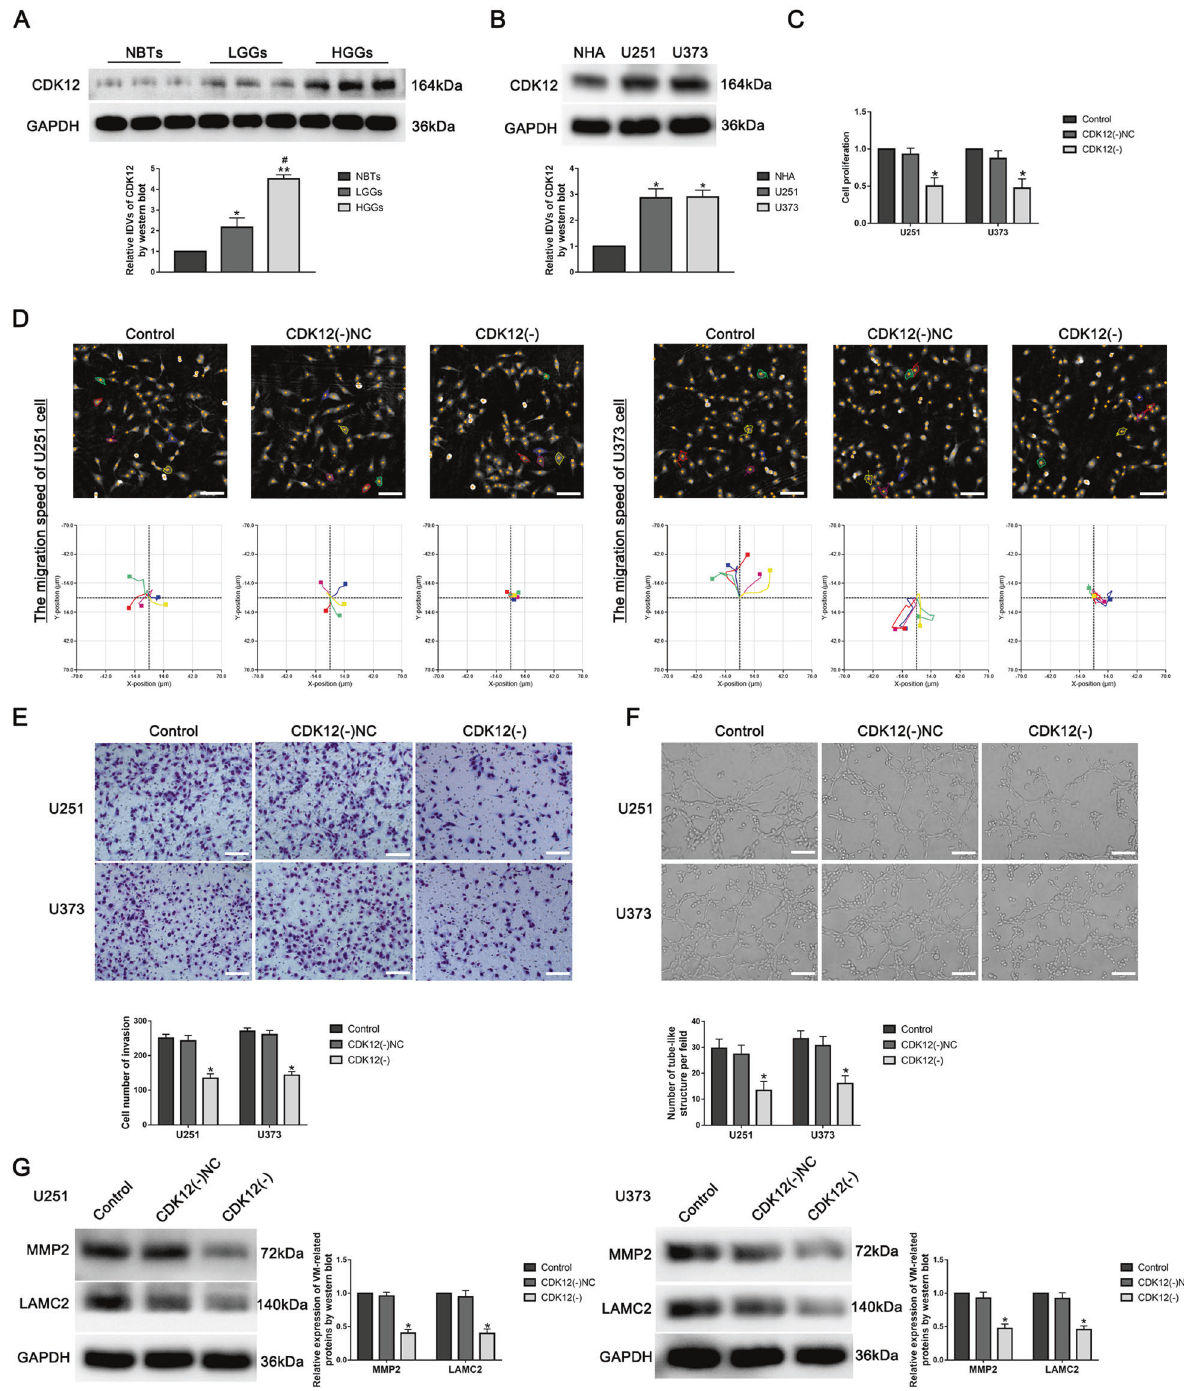
Fig. 3 CDK12 was upregulated in GBM tissues and cells, and knockdown of CDK12 inhibited VM formation in GBM cells. A Western blot was used to detect CDK12 protein expression level in normal brain tissues (NBTs), low-grade glioma tissues (WHO 1 – 2), and high-grade glioma tissues (WHO 3 – 4). Data are presented as mean ± SD ( n = 3). * P < 0.05, ** P < 0.01, compared with NBTs group, # P < 0.05, compared with low- grade glioma tissue group. B Western blot was used to detect CDK12 protein expression level in NHAs, U251, and U373 cells. Data are presented as mean ± SD ( n = 3). * P < 0.05, compared with NHAs group. C The effect of CDK12 on the proliferation of U251 and U373 cells was detected by CCK8 assay. Data are presented as mean ± SD ( n = 3). * P < 0.05, compared with CDK12(-)NC group. D Hstudio M4 was used to detect the effect of CDK12 on the migration of U251 and U373 cells ( n = 5). E Transwell assay was used to detect the effect of CDK12 on the invasion of U251 and U373 cells. Data are presented as mean ± SD ( n = 3). * P < 0.05, compared with CDK12(-)NC group, scale bar: 50 μ m. F Three-dimensional tube formation assay was used to detect the effect of CDK12 on the tube formation ability of U251 and U373 cells. Data are presented as mean ± SD ( n = 3). * P < 0.05, compared with CDK12(-)NC group, scale bar: 50 μ m. G Western blot was used to detect the effect of CDK12 on VM-related proteins MMP2 and LAMC2 expression in U251 and U373 cells. Data are presented as mean ± SD ( n = 3). * P < 0.05, compared with CDK12(-)NC group. Cell Death and Disease (2022)